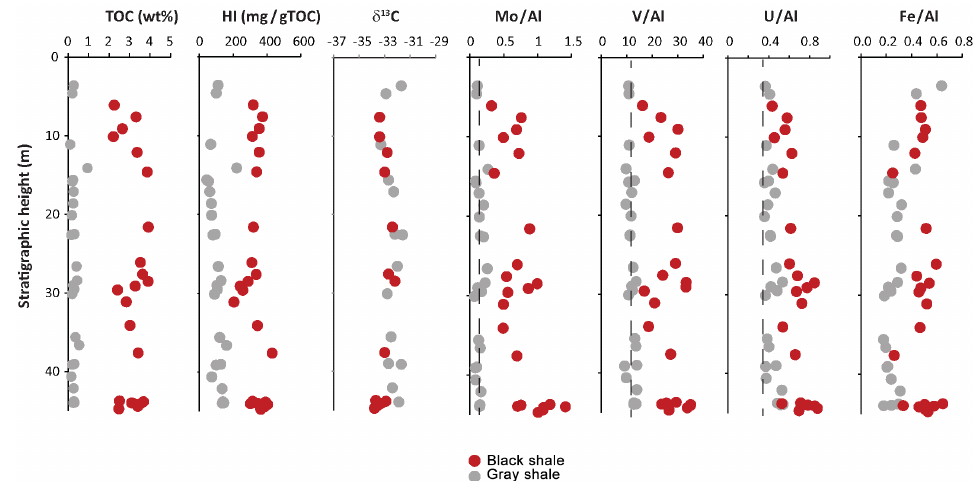
Figure 2. Total organic carbon (TOC), HI, δ 13 C (relative to PDB) and metal data (Mo / Al, V / Al and U / Al, Fe / Al) for unit 1 of the Xiamaling Formation. The dashed line represents upper crust values from Rudnick (2004).